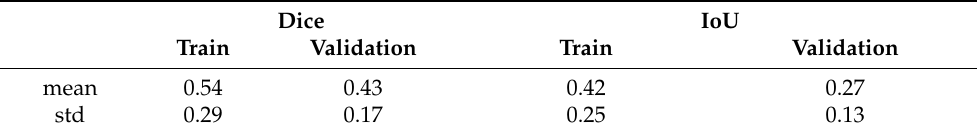
Table 2. U-Net model train and test results (Dice